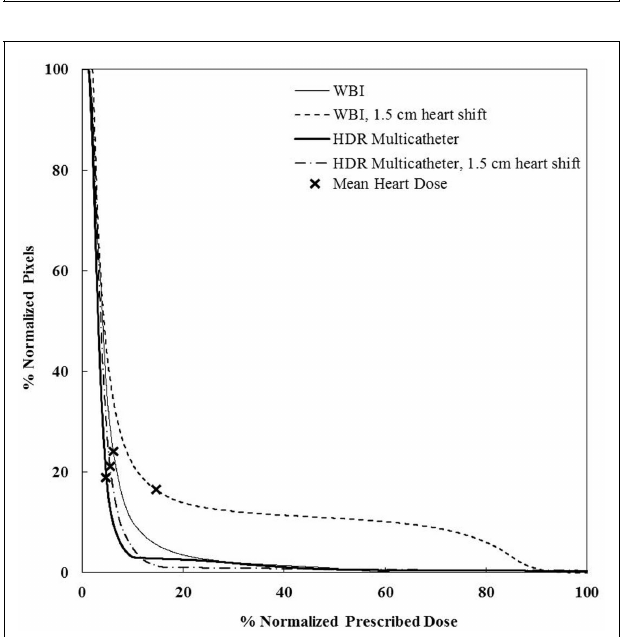
FIGURE 9 | Cumulative DVHs for the sensitivity analysis on set-up error and motion effect for a medium sze breast and a medially located seroma .There is little impact of those factors for HDR, but a dramatic effect forWBI.WBI, whole breast irradiation; HDR, high-dose